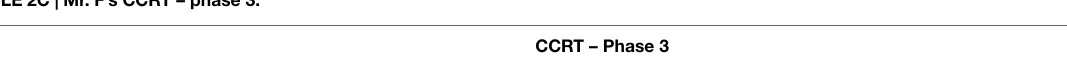
TABLE 2C | Mr. F’s CCRT – phase